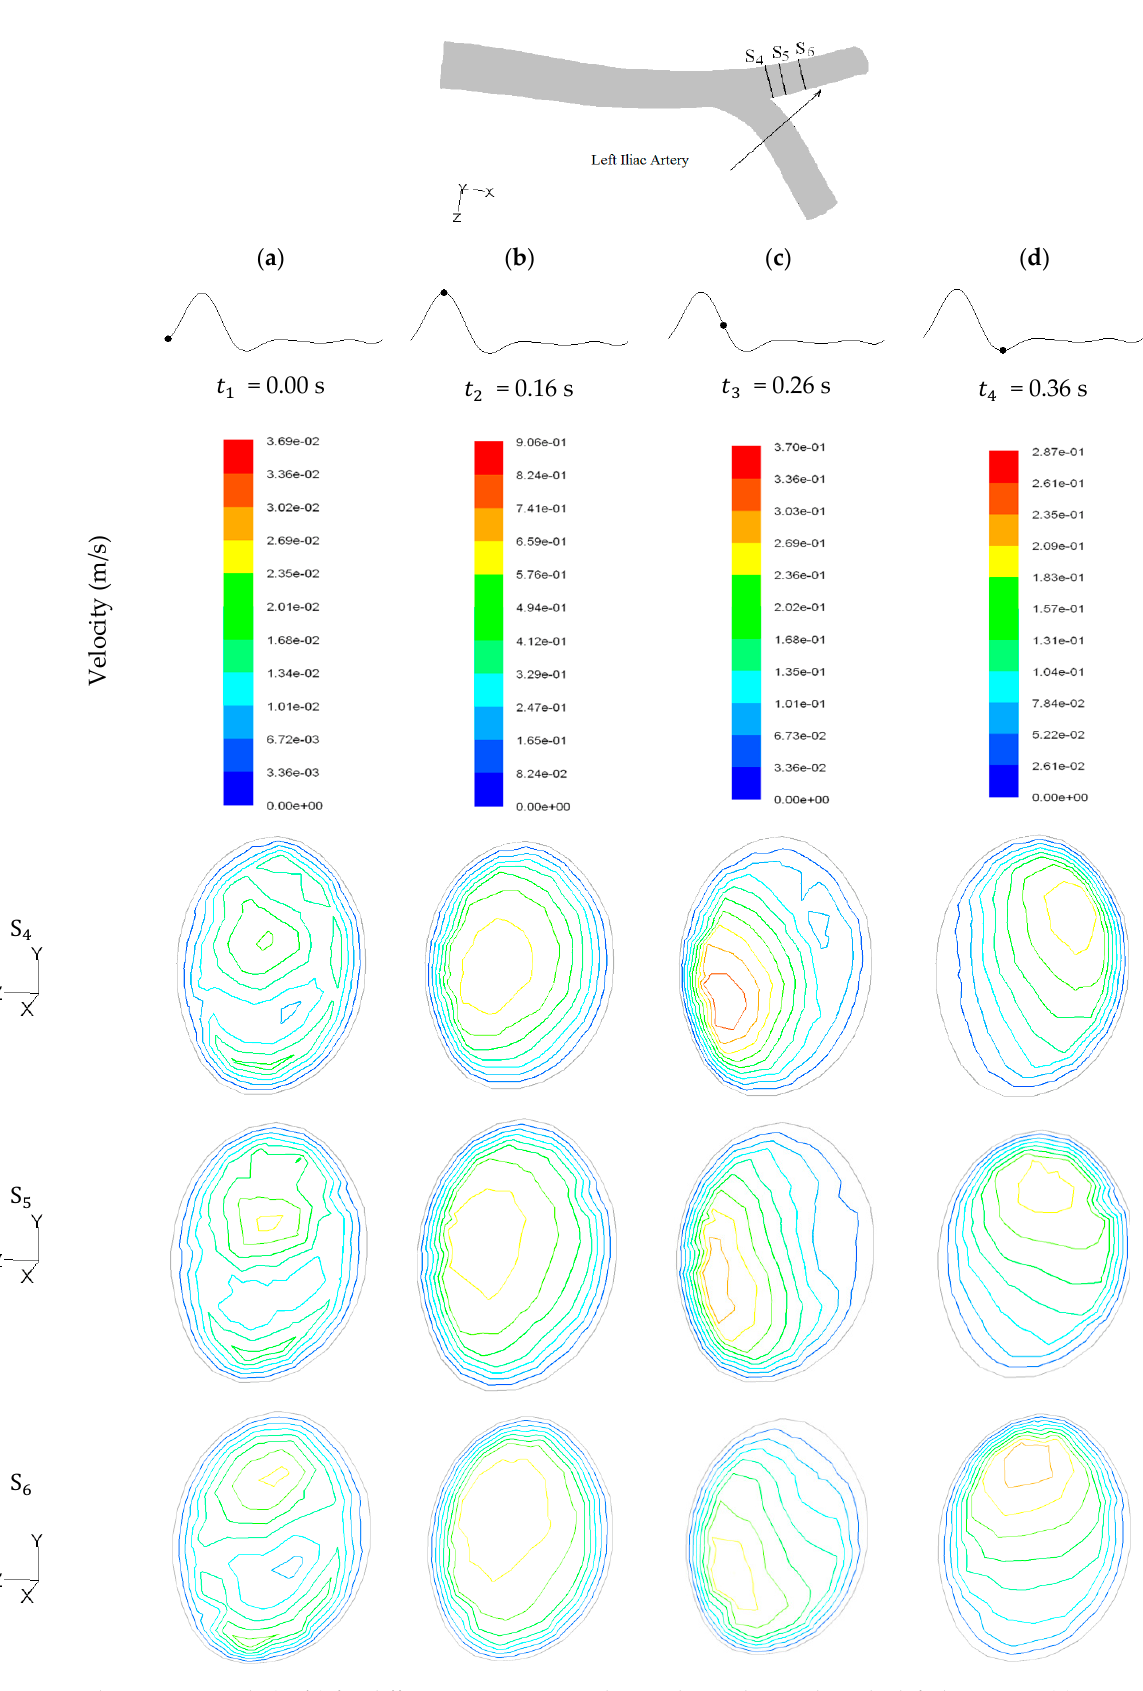
Figure 14. Velocity magnitude (m/s) for different cross-sections during the cardiac cycle at the left iliac artery, ( a ) t = 0.00 s, ( b ) t = 0.16 s, ( c ) t = 0.26 s, ( d ) t = 0.36 s.